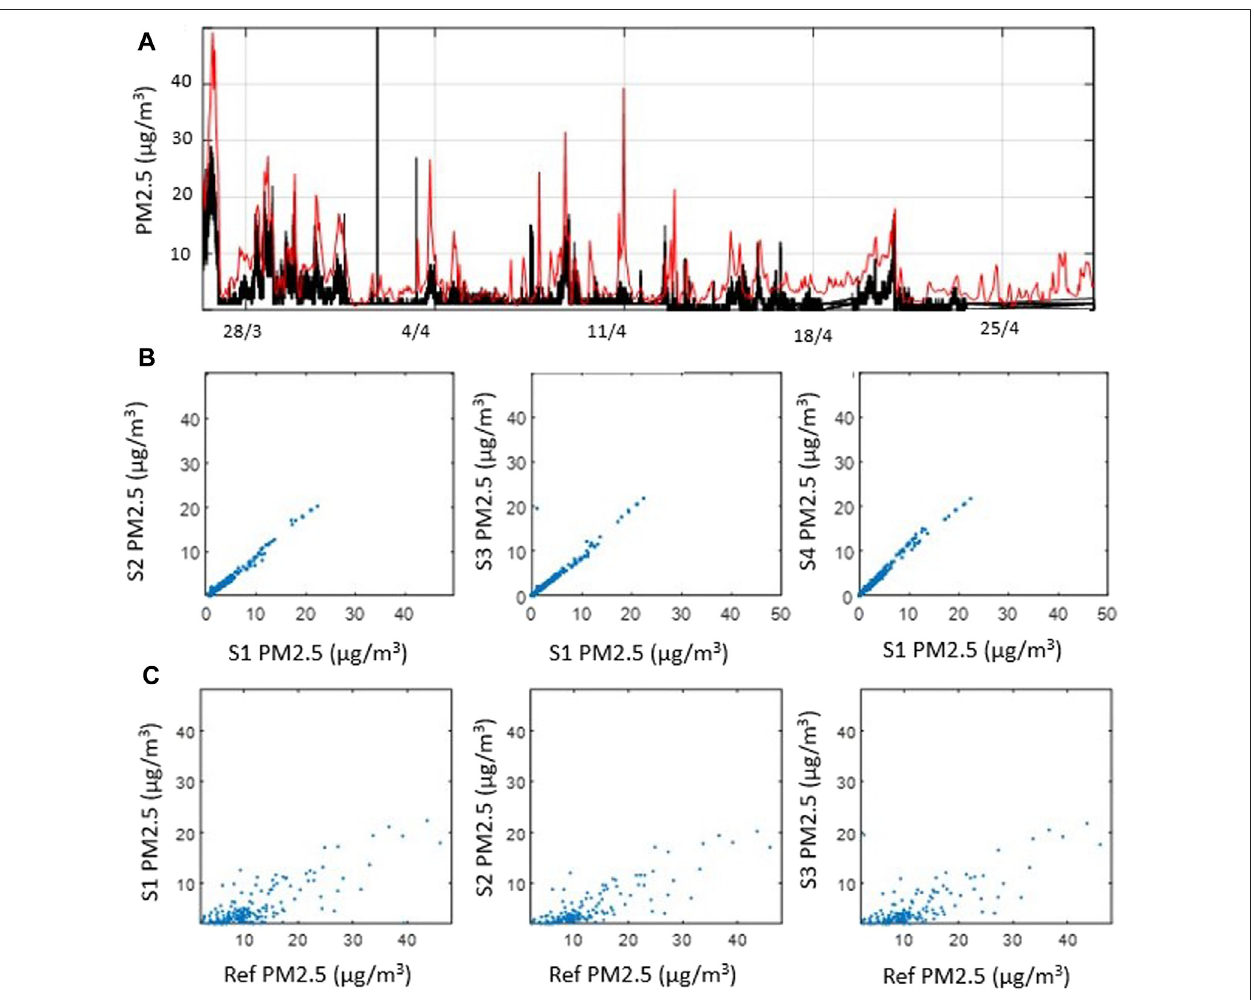
FIGURE 1 | (A) Time series showing data from all 11 evaluated LCS (black) and nearby reference station (red), (B) inter-comparison of co-located PM 2.5 measurementsfromthreerepresentativesensors,and (C)